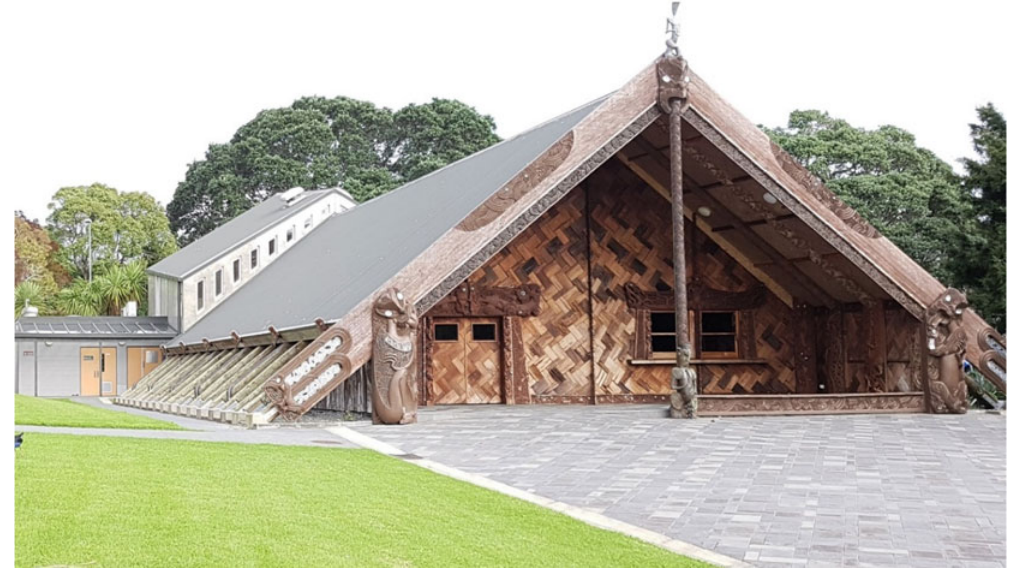
Fig. 2. Ng ā kau M ā haki , the Whare Whakairo (carved meeting house), Te Noho Kotahitanga Marae, Unitec, Auckland. July 14,